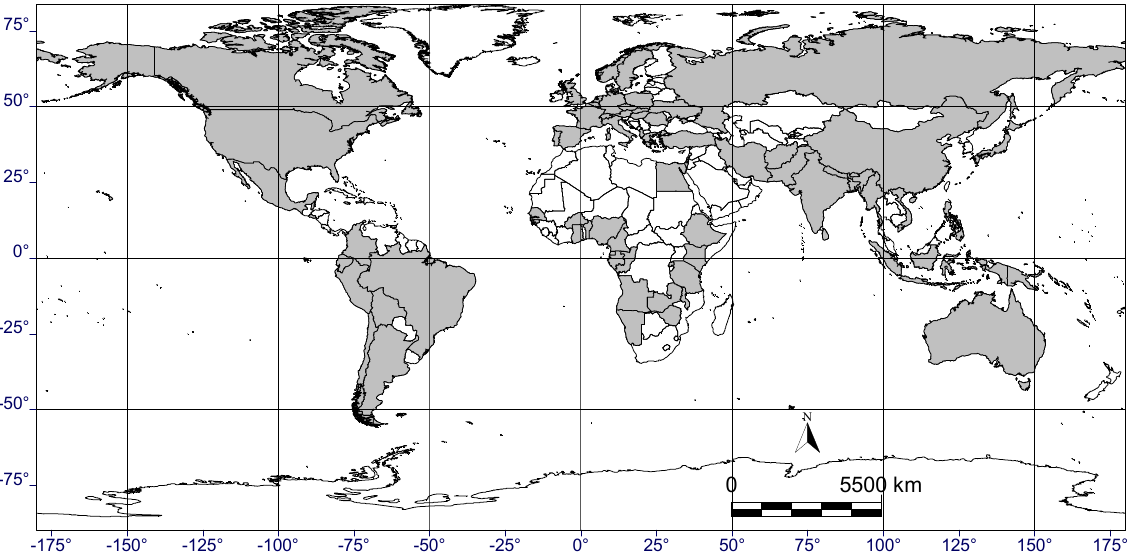
Figure 7. Study areas per country from the 250 papers analyzed. Source: own elaboration.